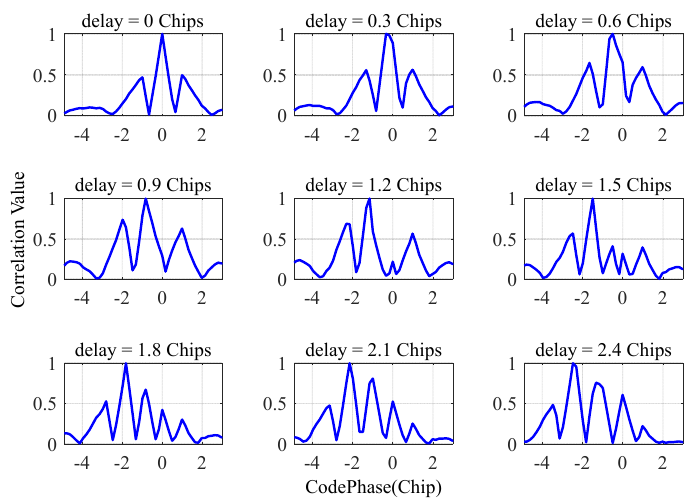
Figure 8. The effect of mixed interference on the correlation peaks.